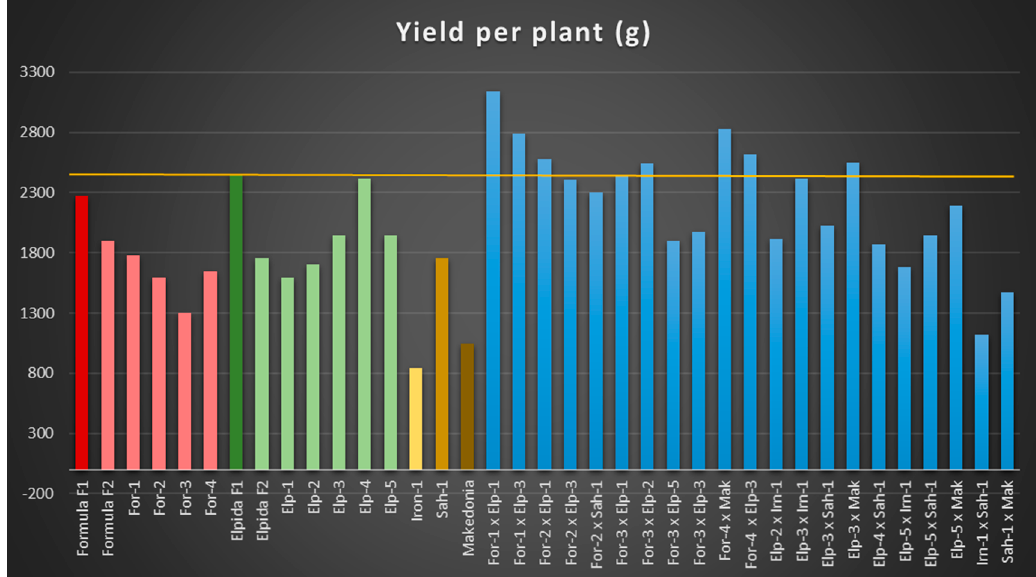
Figure 2. Total production for yield per plant (g), of the original F 1 commercial hybrids, new recombinant inbred lines, and the new reconstructed hybrids. Table 2. Total production for yield per plant (g), fruit number per plant, and fruit weight (g) of the